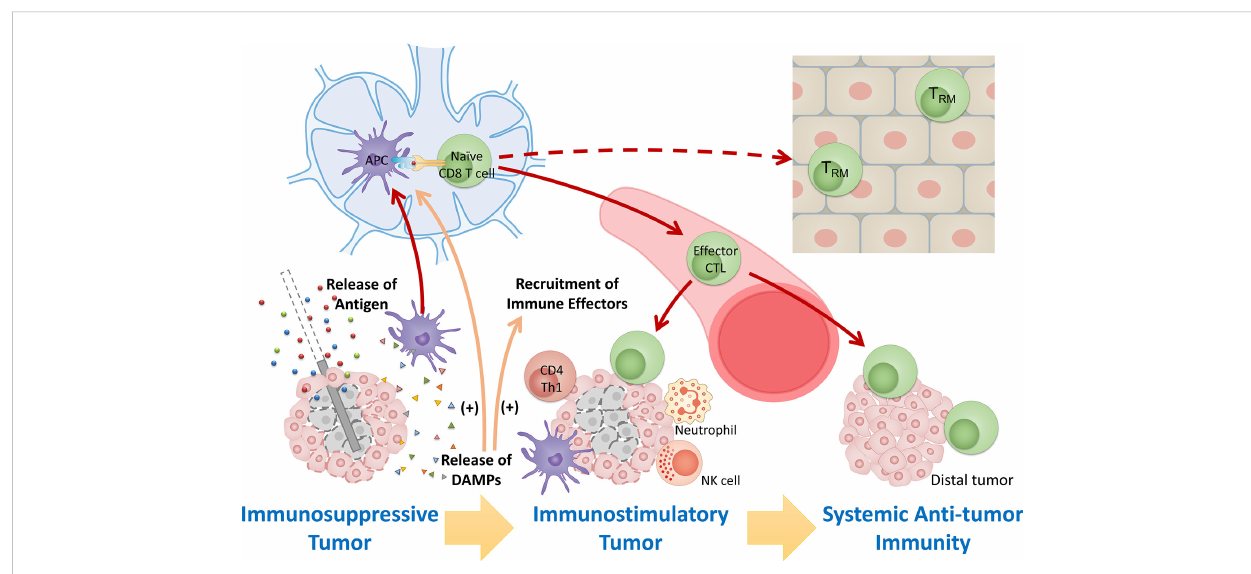
FIGURE 1 Overview of immunomodulatory effect after FT. Tumor destruction by FT releases large amount of tumor antigens and immunostimulatory DAMPs, leading to antigen presentation and activation of immunity, recruitment of immune effectors, and mitigation of immunosuppression. The response stimulates systemic anti-tumor immunity and induces maintenance of tissue-resident memory cells involved in local immunosurveillance, leading to potential long-lasting protection against